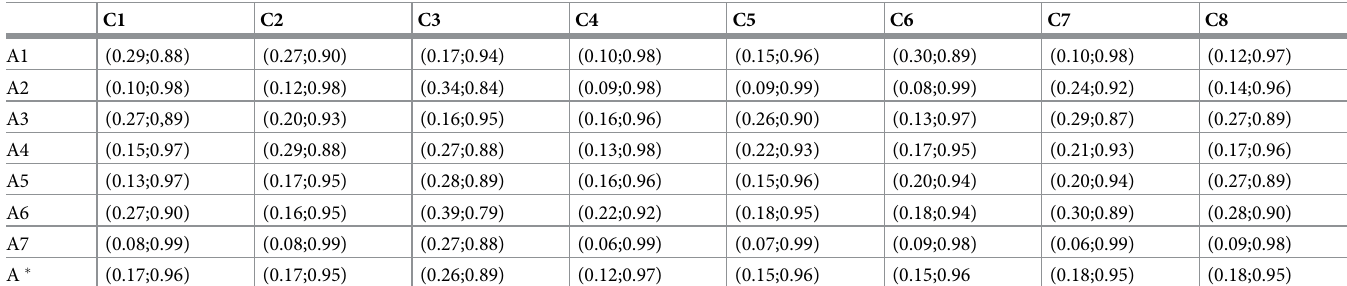
Table 6. Pythagorean fuzzy decision matrix and average solution.